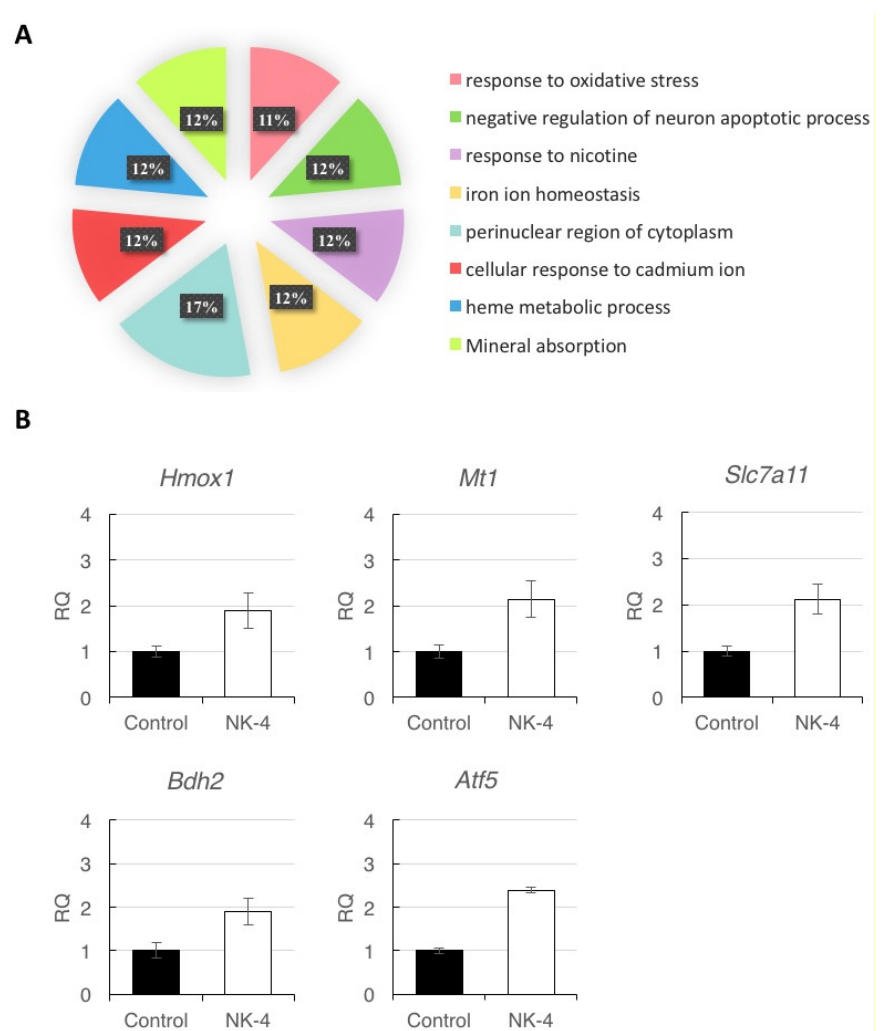
Figure 7. ( A ) Analysis of affected functional processes of DEGs. DEGs were submitted for DAVID analysis, and affected functional processes are shown. Significance was accepted at a Benjamini–Hochberg p value of less than 0.01. ( B ) Quanti- tative reverse-transcription PCR analysis of Hmox1 , Mt1 , Slc7a11 , Bdh2 , and Atf5 expression in retinal samples. Since indi- vidual rats exhibited differences in expression levels of genes, data represent the mean ± SD obtained for measurements from triplicate wells and are representative of three individual rats. RQ : relative quantification